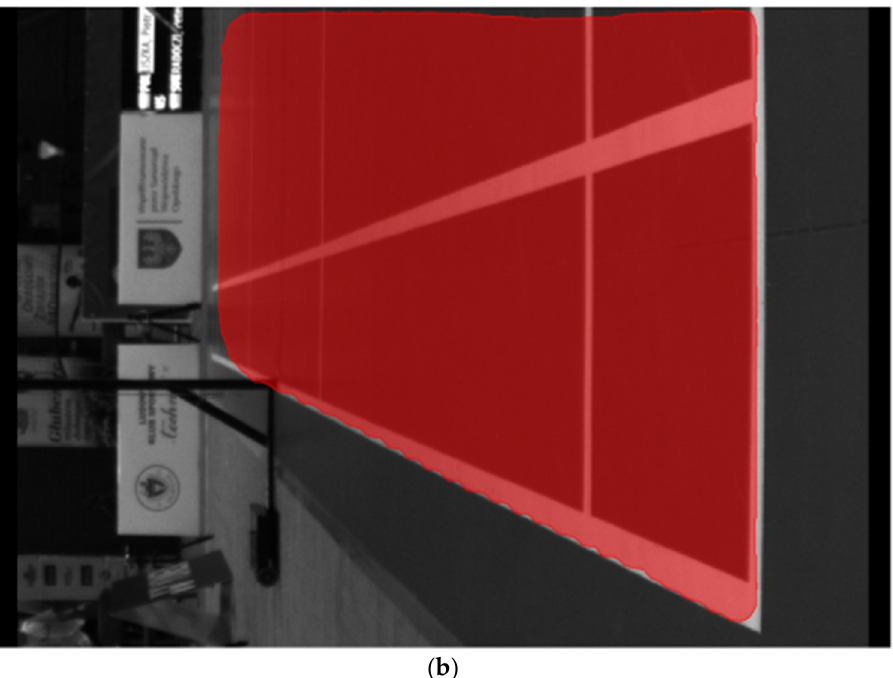
Figure 4. Masks of detected court: top, ( a ) original layers; bottom, ( b ) increased number of layers.